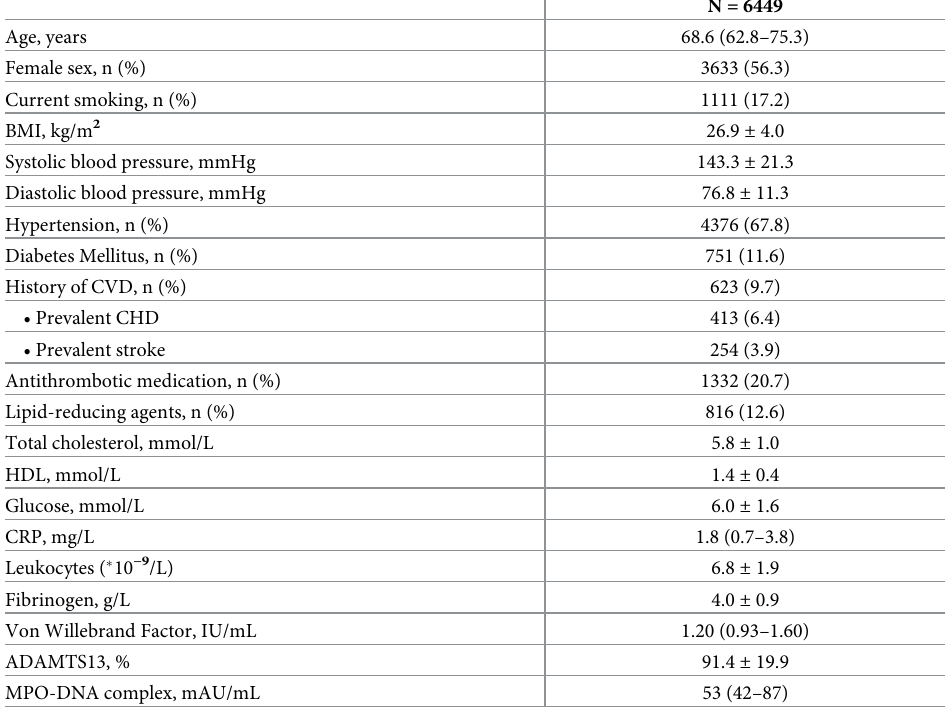
Table 1. Baseline characteristics of the total